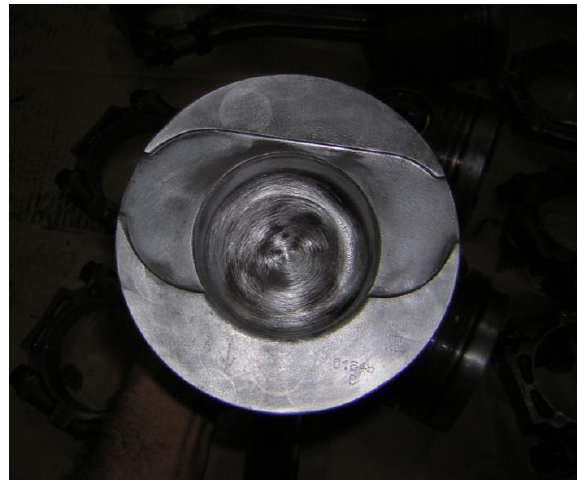
Figure 2. Piston head of the engine studied in the present